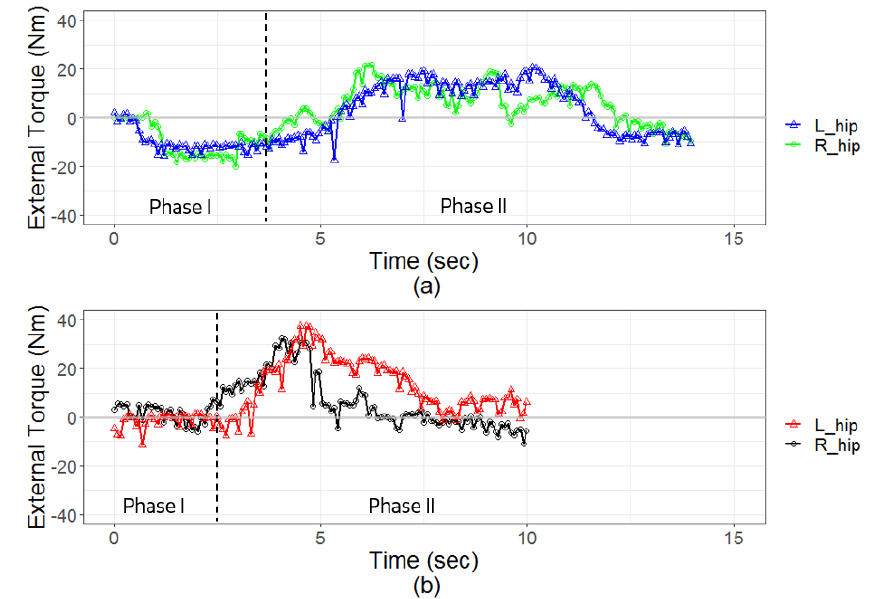
Figure 11. External torque measured from the hip joint using the correct ( a ) and incorrect ( b ) methods of standing